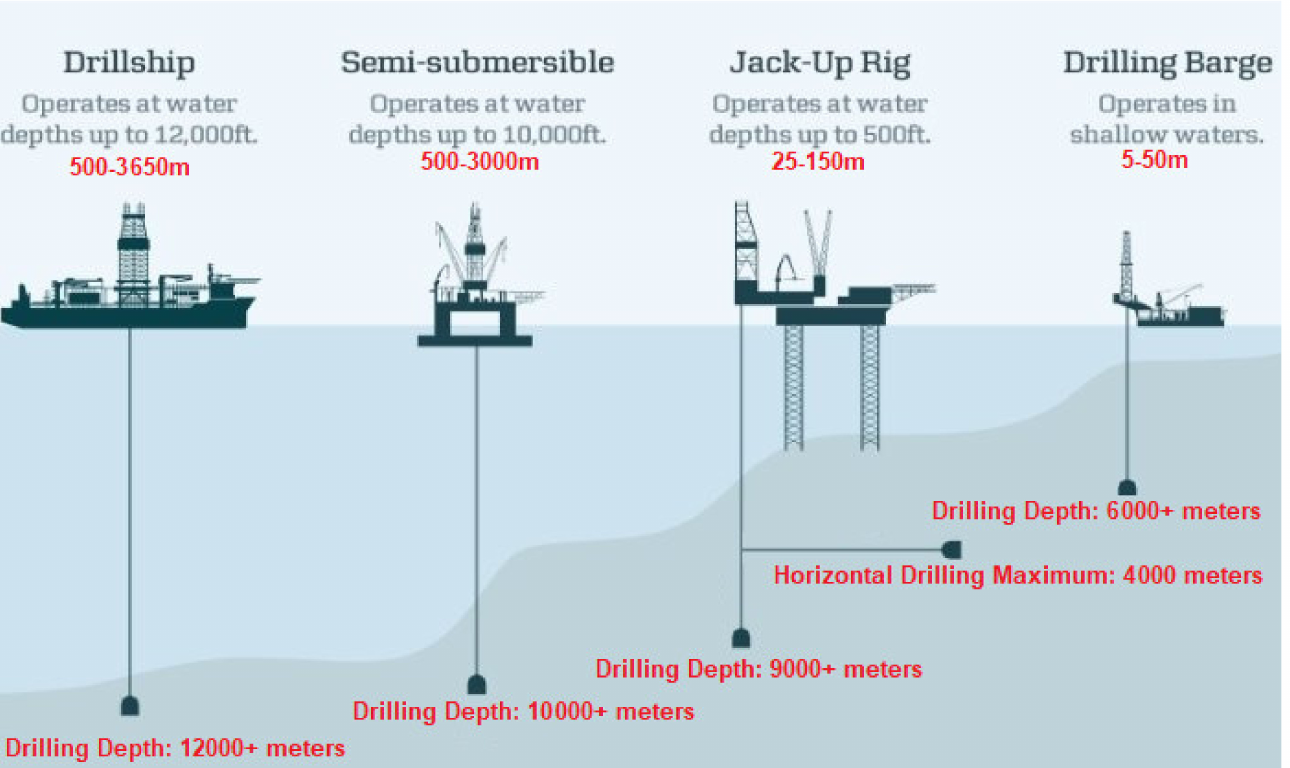
Figure 6. Types of Drilling